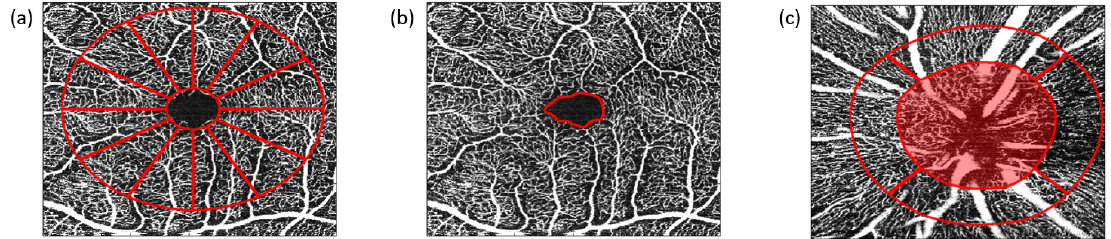
Figure 6. Optical coherence tomography angiography (OCT–A): ( a ) Schematic sketch of quantitative OCT–A analyses of the macula (12 sectors, at 30 ◦ ), ( b ) foveal avascular zone (FAZ, red), and ( c ) the peripapillary region (4 sectors, at 90 ◦ ), quantified by the Erlangen-Angio Tool; quantification of vessel density was performed by implementation of the Anatomic Positioning System (APS, part of Glaucoma Module Premium Edition [GMPE], Heidelberg Engineering, Heidelberg, Germany) considering each individual anatomy. The APS can be done by fixation of two points, the fovea and the center of the Bruch’s Membrane Opening (BMO), and the subsequent adjustment of the image to each individual Fovea-to-Bruch’s Membrane Opening-Center (FoBMOC). Peripapillary OCT–A scans were analyzed as BMO-based.